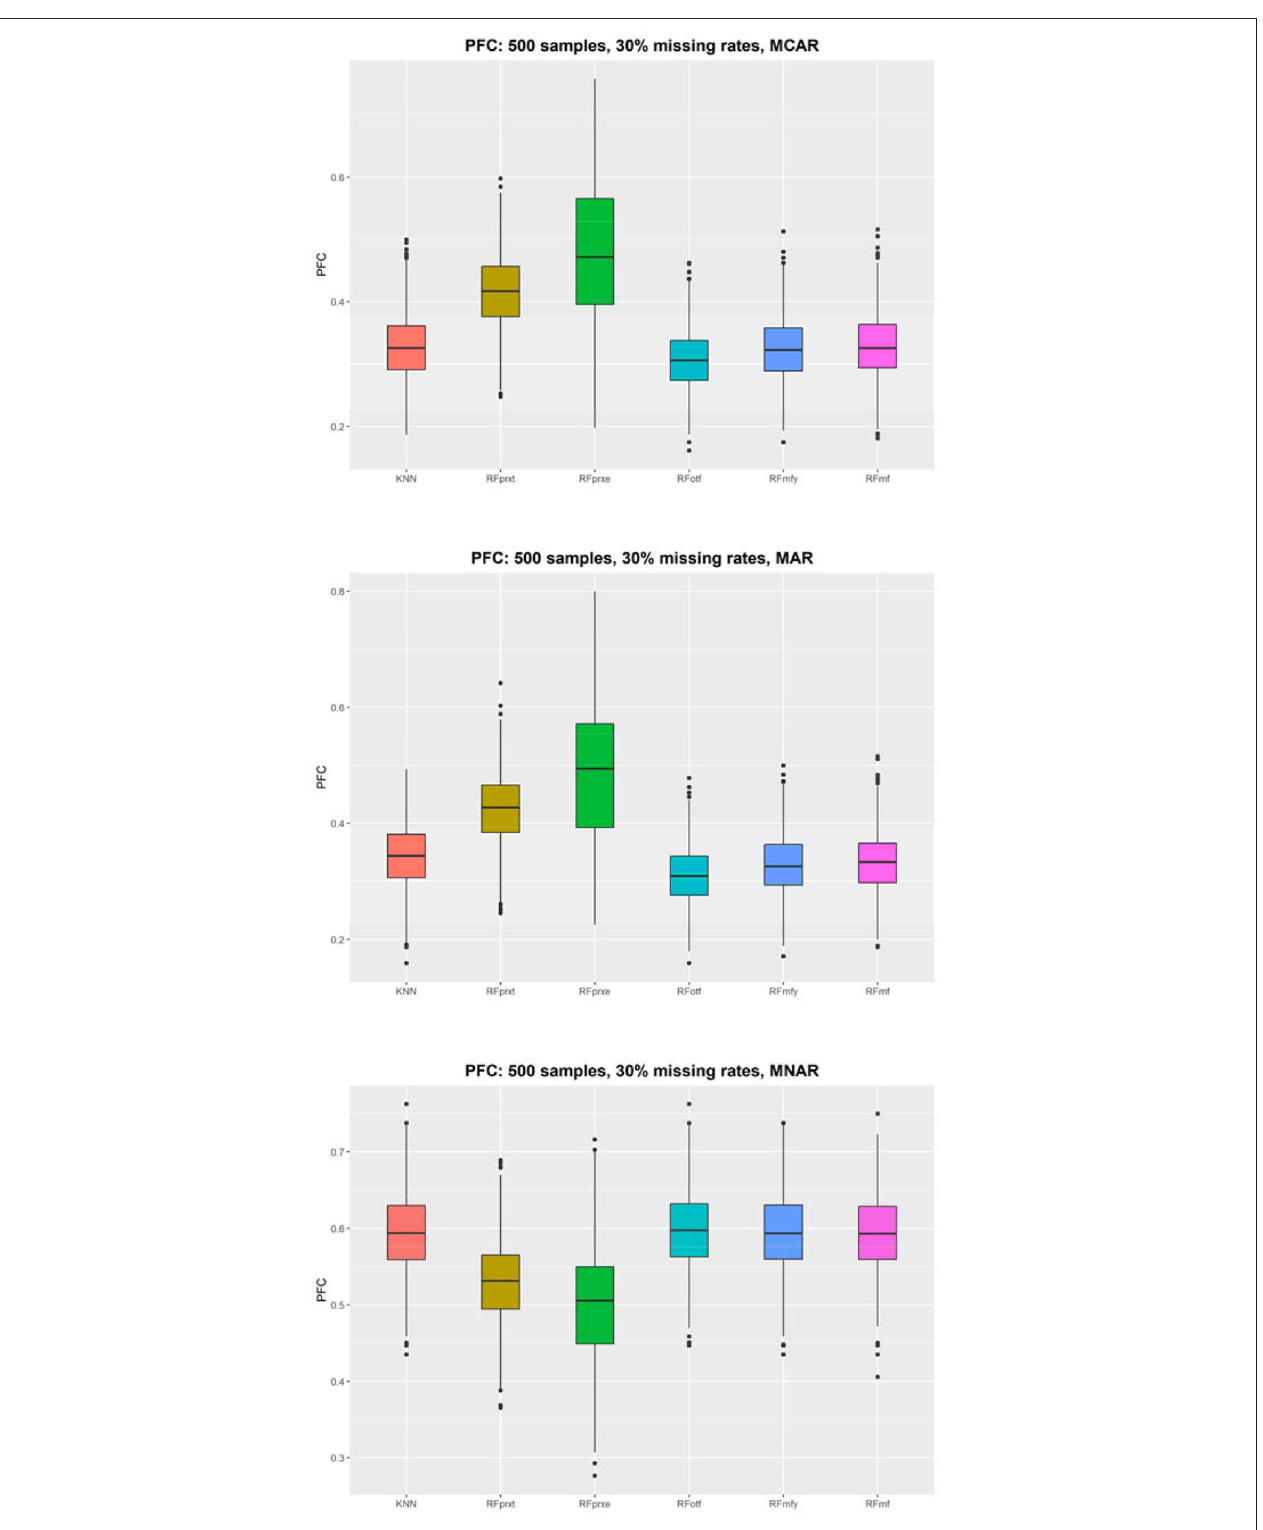
FIGURE 1 | The proportion of falsely classified (PFC) using 500 subjects.